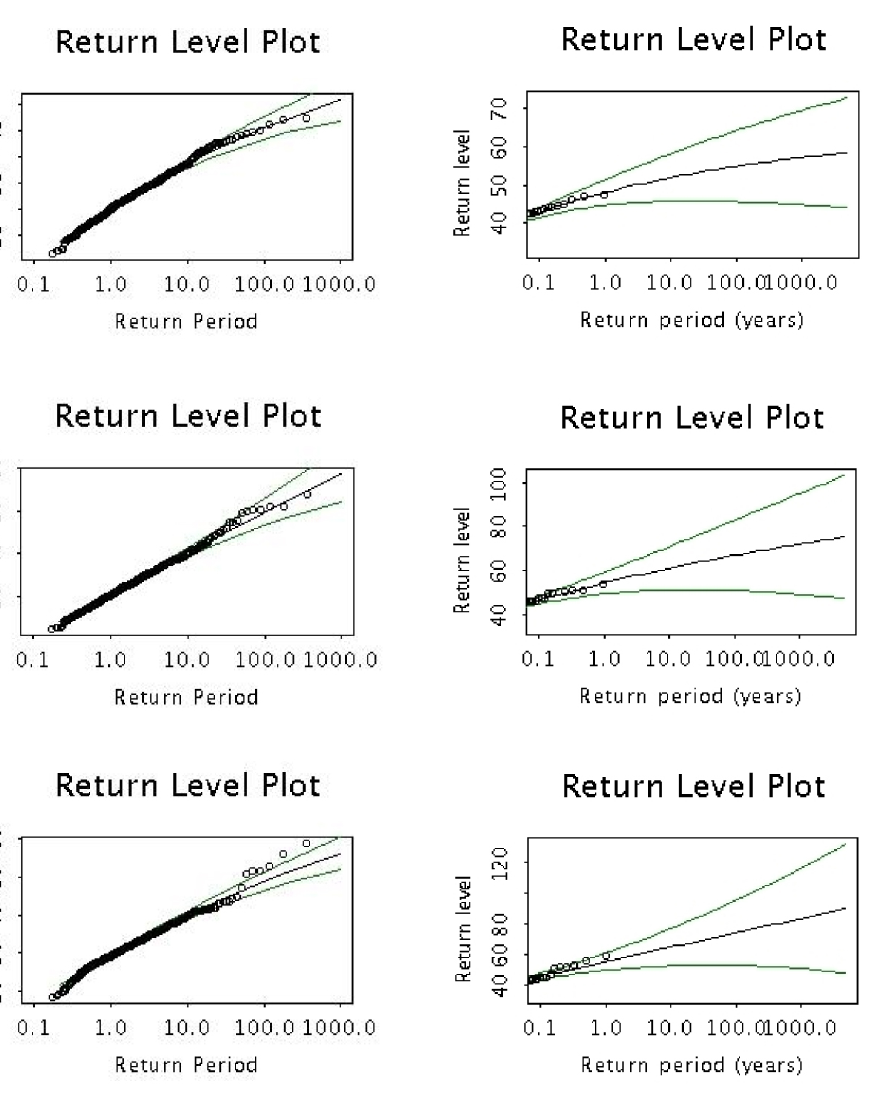
Fig. 4. Return level plot (cms − 1 ) for the surge component at location FB, depths 349, 499 and 649m from top to bottom. 95% confidence interval is also shown. The return period is in years when considering the results from the GPD (right column) but it is in days for the results from the GEV